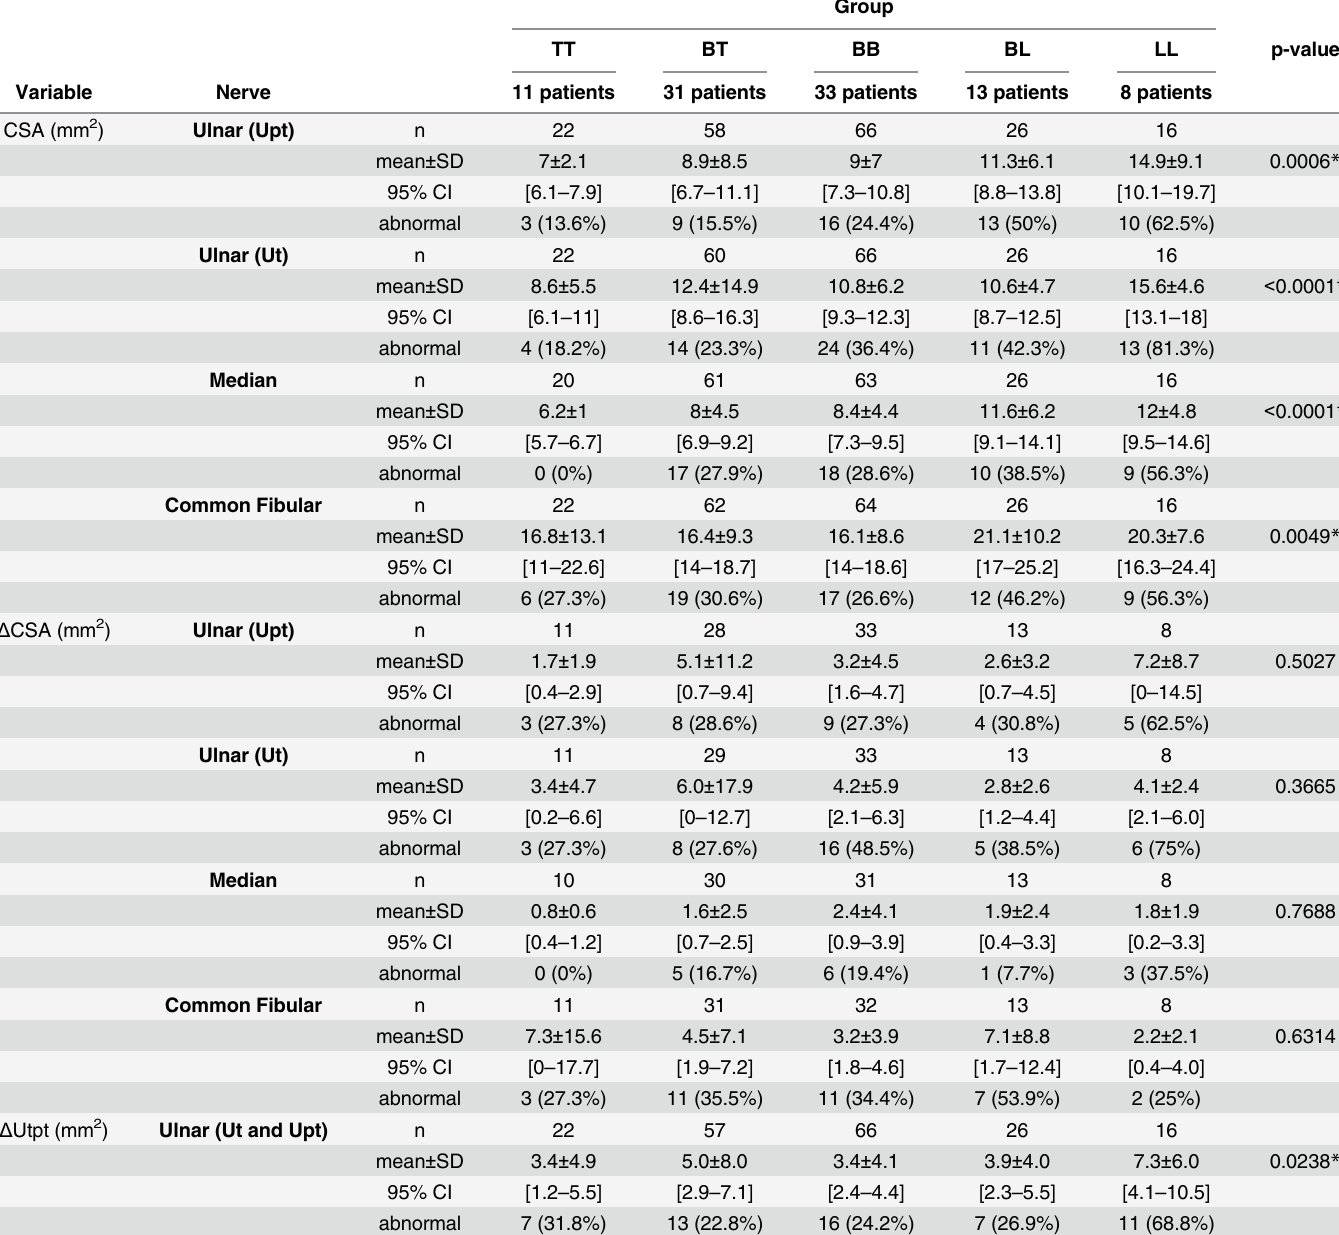
Table 2. CSAs, Δ CSAs and Δ Utpt results. Patients were classified according to the Ridley-Jopling